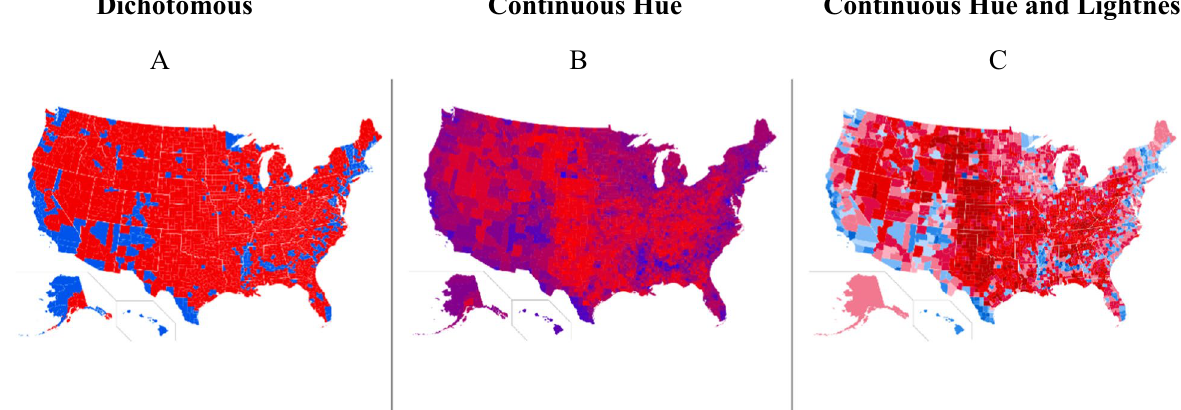
Fig. 1 Three different approaches to designing red/blue maps that represent the outcome of the 2016 election at the county level. A: Dichotomous solution. The counties where Donald Trump received the most votes are colored red and the counties where Hillary Clinton received the most votes are colored blue. B: A continuous hue solution. Counties are shaded according to winning candidate’s percentage of the vote, with purple counties being closer races and redder or bluer counties having a larger margin in favor of Trump or Clinton, respectively. C: A continuous hue and lightness solution, where base hue (red or blue) indicates which candidate won the county, and lightness indicates the margin by which a candidate won a county (darker colors indicate larger margin). Prior work suggests judgments about polarization are reduced by solution B relative to solution A, but no work has compared solution C (Rutchick et al., 2009). Furthermore, no work has compared the effect of solution A relative to an absence of red–blue coding or to an arbitrary hue mapping to isolate general effects of hue on category representation from the effect of prior knowledge about the significance of red and blue in